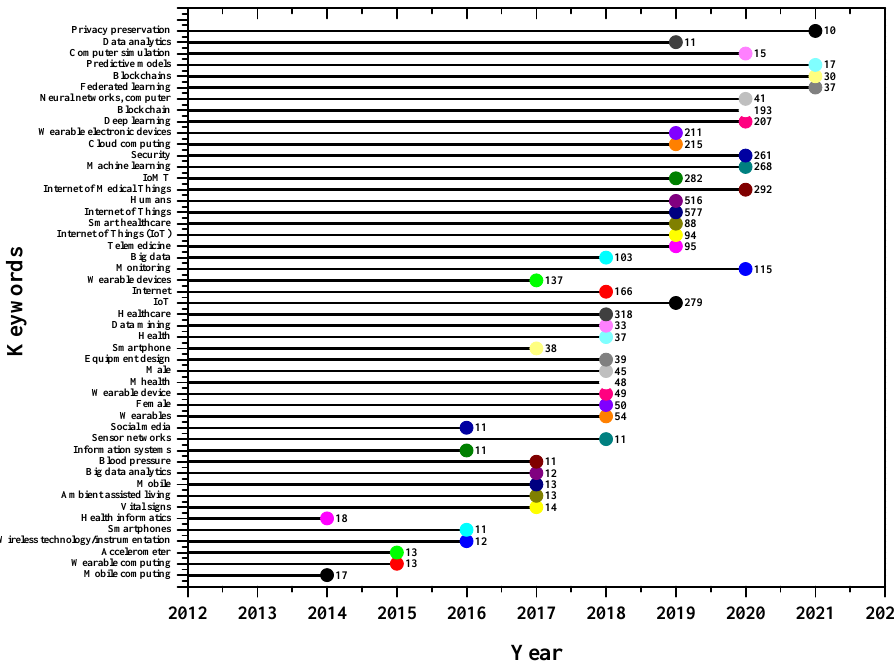
Figure 18. The trending topics; Minimum count was set to 10 each